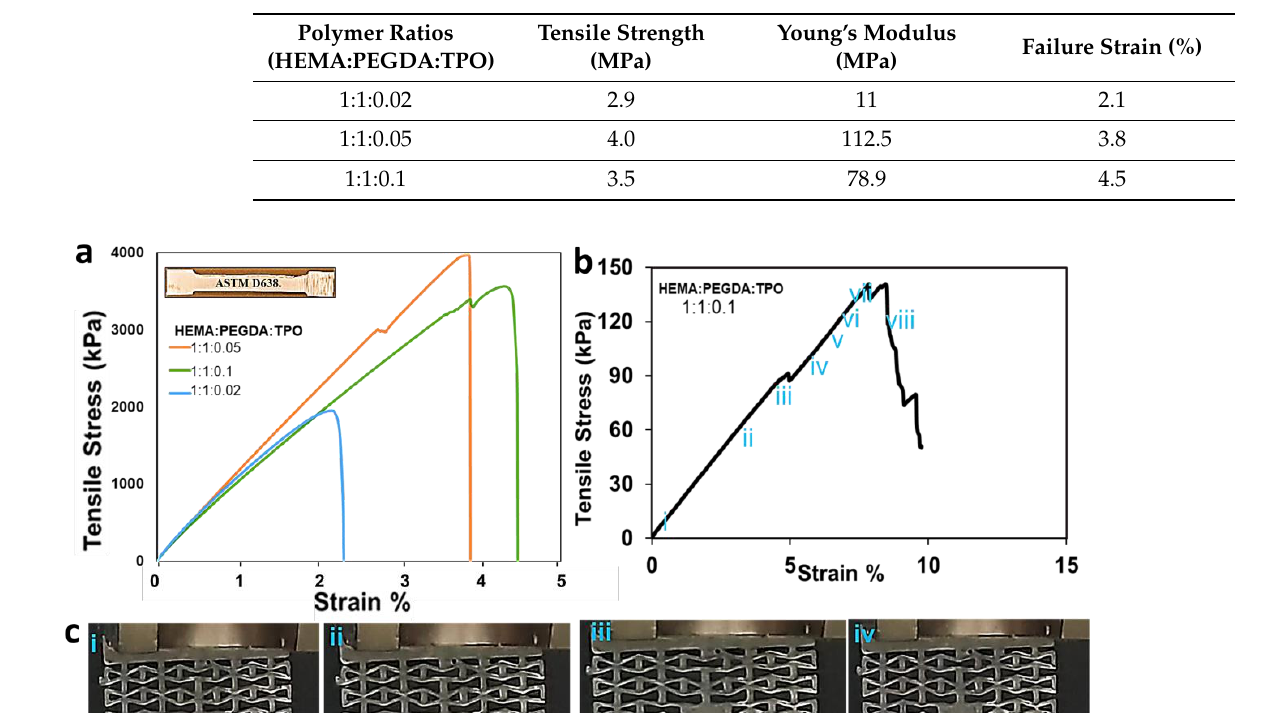
Table 1. Mechanical characteristics of 3D printed hydrogels with different proportions of HEMA: PEGDA: TPO.